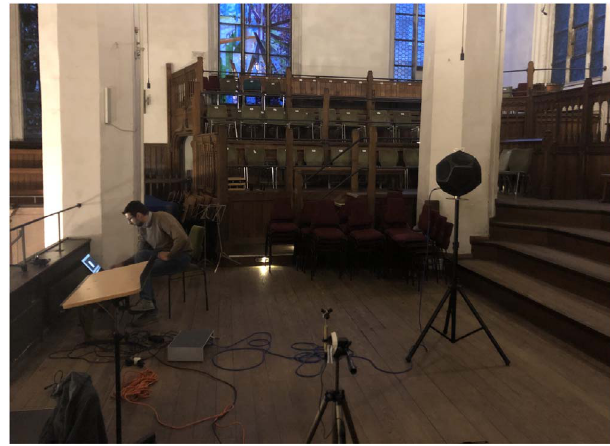
Figure 3. Dodecahedral loudspeaker and TetraMic in the west